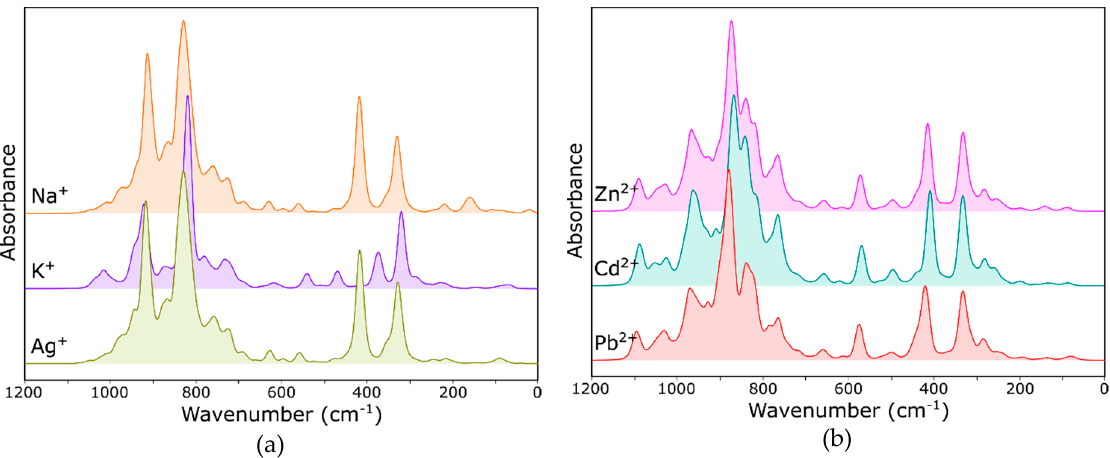
Figure 3. IR spectra of FAU: ( a ) calculated for exemplary monovalent cations and the “C” model and ( b ) calculated for exemplary divalent cations and the “B” model.